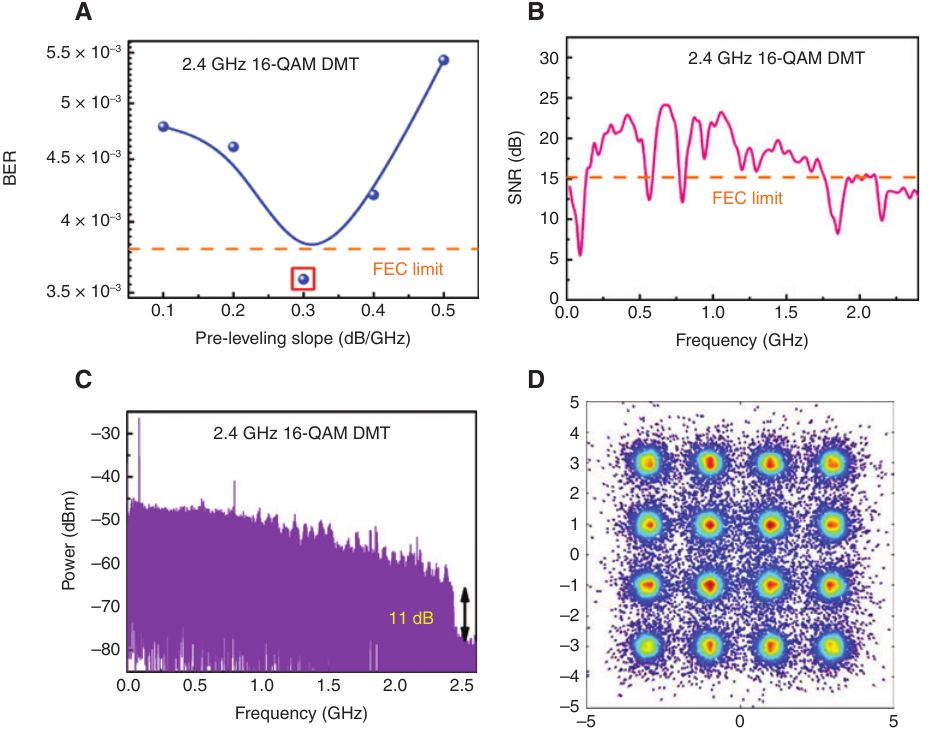
Figure 9: The performance improvement of the 16-QAM DMT data carried by the VLD + CdSe/ZnS core-shell-QD based white-lighting source with the